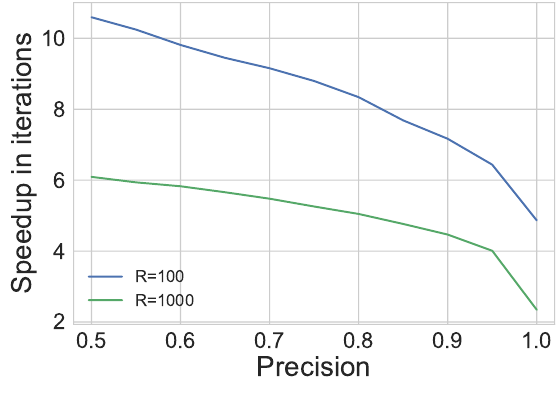
Figure 5. Speedup in